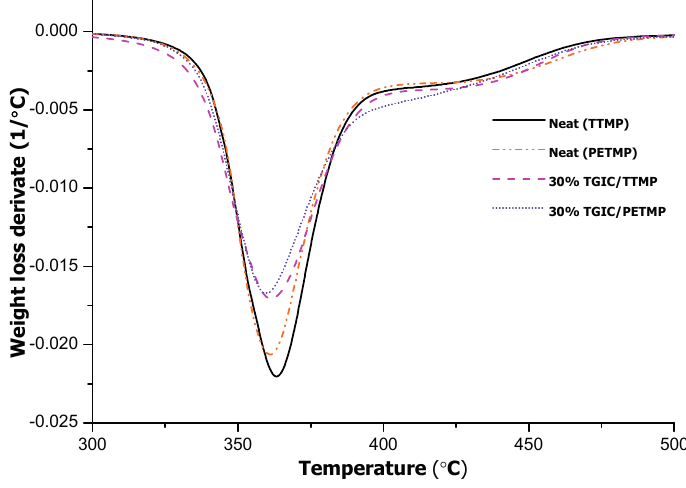
Figure 7. DTG curves registered under N 2 at 10 K/min of thermosets obtained by using TTMP and PETMP as curing